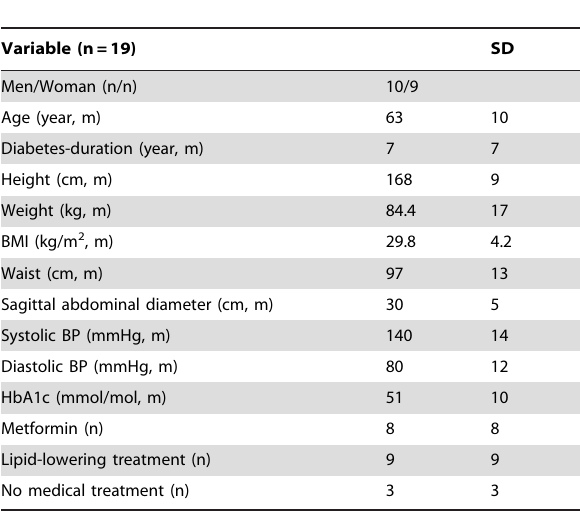
Table 2. Baseline characteristics of the patients in the morning of the first individual test